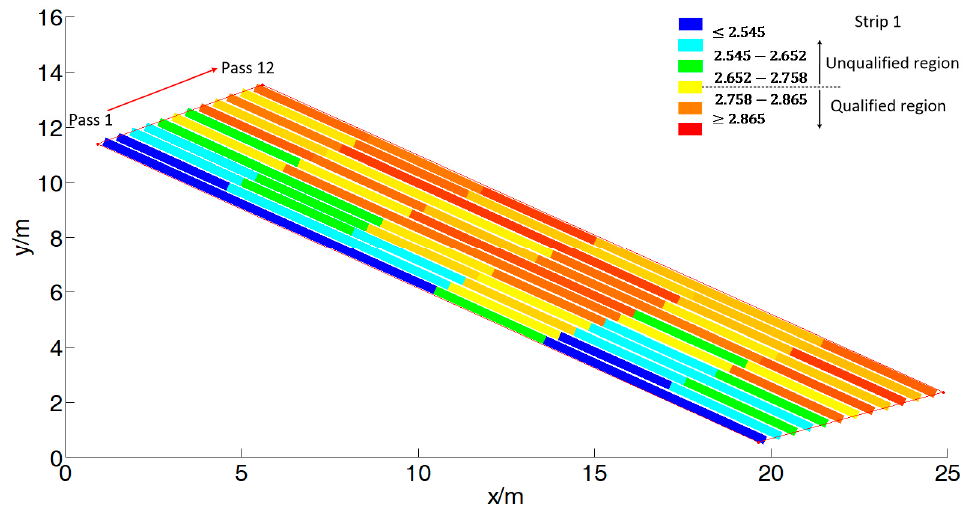
Figure 19. Compaction nephogram of Strip 1 using SCV.